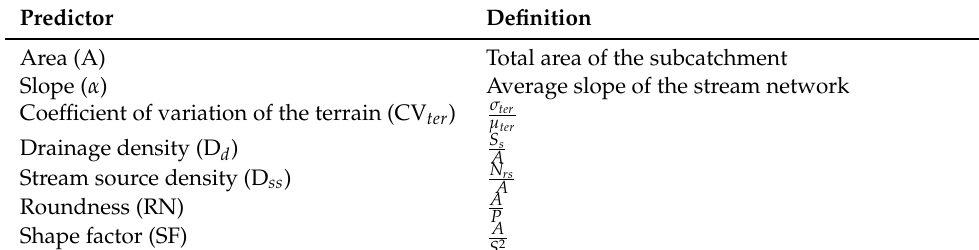
Table 1. Variables used to construct the GBRT model for estimating CS